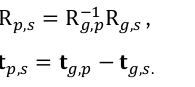
the white circle can be found by fitting a circle (light blue) with the known radius to the points.